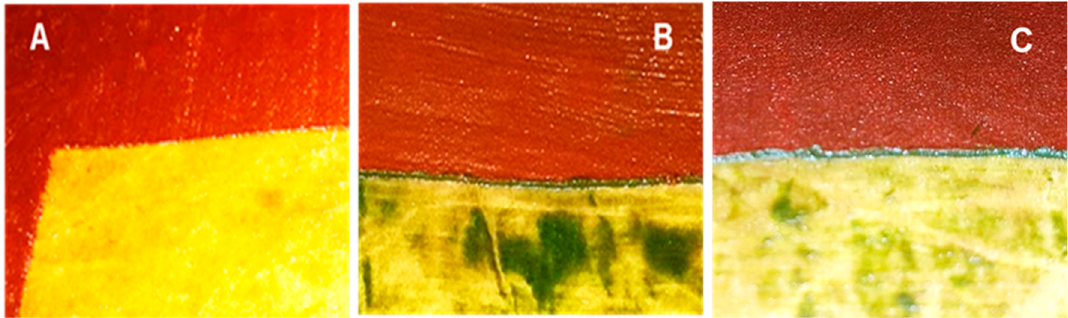
Figure 10. The H. pluvialis biofilm at initial dry biomass density of 2.5 g m –2 ( A ), 7.5 g m –2 ( B ) and 10 g m –2 ( C ) after 6 days of cultivation.